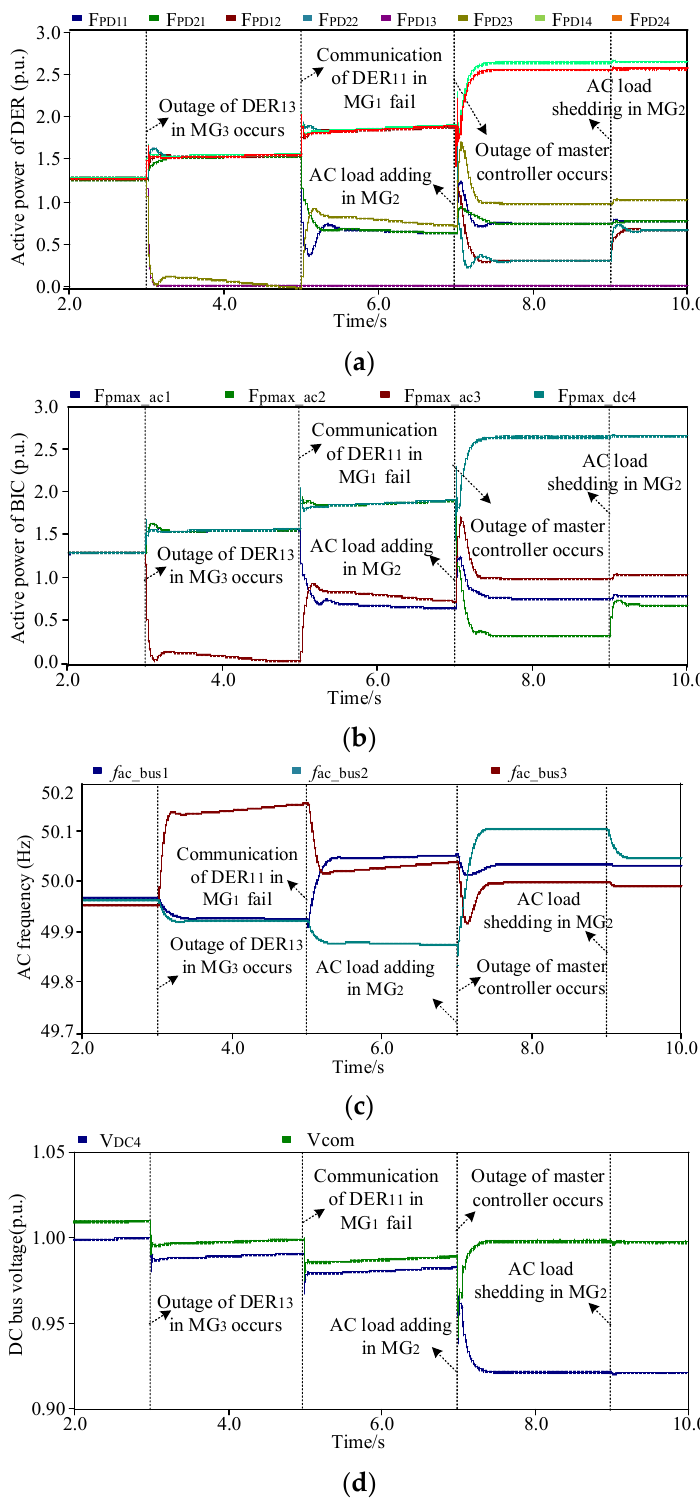
Figure 17. Performance of conventional centralized control under outages and communication failures of the pinned DERs and the master processing controller: ( a ) Output power of AC/DC DERs, ( b ) Output power of BICs, ( c ) Frequencies of AC MGs, ( d ) Voltages of common bus and DC MG . With the consensus-based distributed control, the DERs within each MG need to ex- change data with their neighbors, the DER 1j is set as the fixed pinned DERs in each MG to perform a consensus algorithm to achieve power management among MGs. Figure 18 shows the results when outages and communication failure of the pinned DER within MGs occur. When outage of the pinned DER 13 in MG 3 occurs at T = 3 s, the power sharing, and voltage/frequency regulation functions within MG 3 can be maintained, but the power interaction with the other MGs will fail directly. When the communication of the pinned DER 11 in MG 1 fails at T = 5 s, the power management functions within MG 1 still can be realized, but both the power sharing and frequency conditions of MG 1 will deviate from the outside system since the communication among MG 1 and the other MGs has failed.